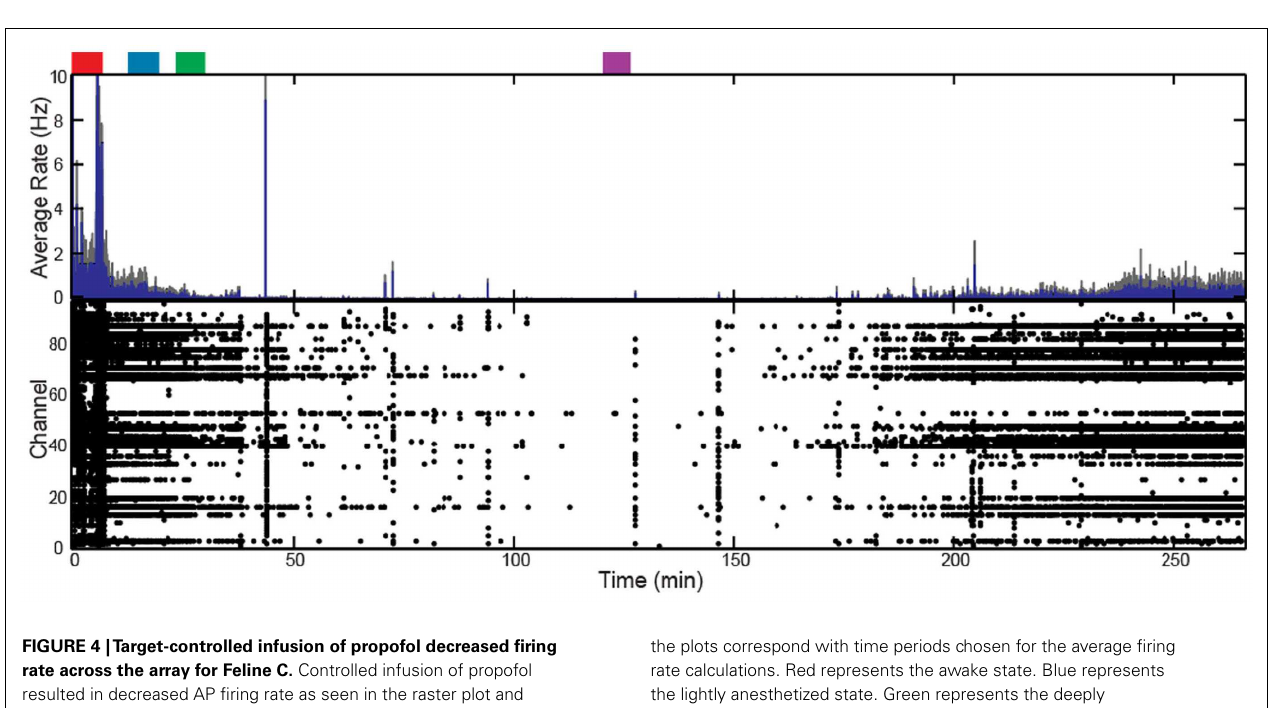
FIGURE 4 |Target-controlled infusion of propofol decreased firing rate across the array for Feline C. Controlled infusion of propofol resulted in decreased AP firing rate as seen in the raster plot and firing rate histogram.The blue line represents the firing rate histogram and the gray dashed lines represent an interval of 4 standard errors wide centered at the mean. Colored rectangles above